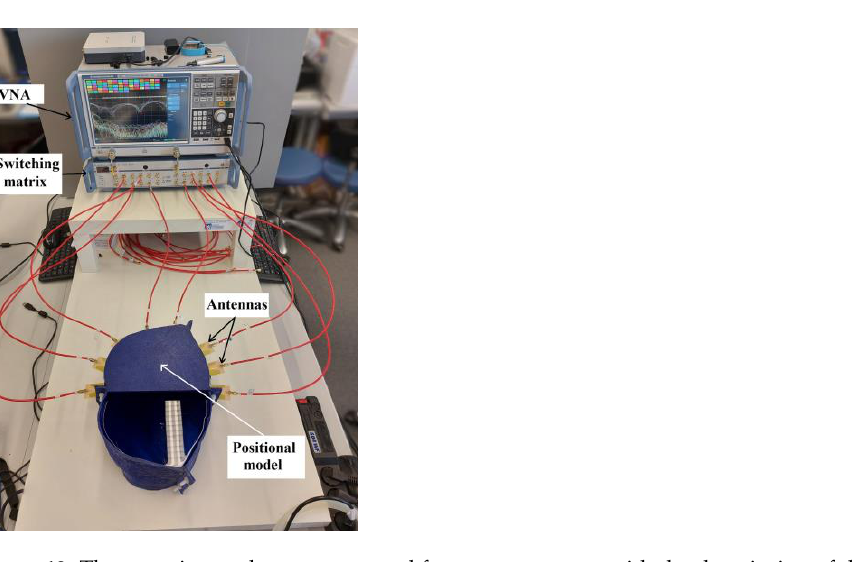
Figure 11. Catheter positions: ( a ) Numerical model of the treatment area with three selected catheter positions; ( b ) 3D printed structure for holding catheters’ mockups (sections of copper wire) in the corresponding positions during experiments.